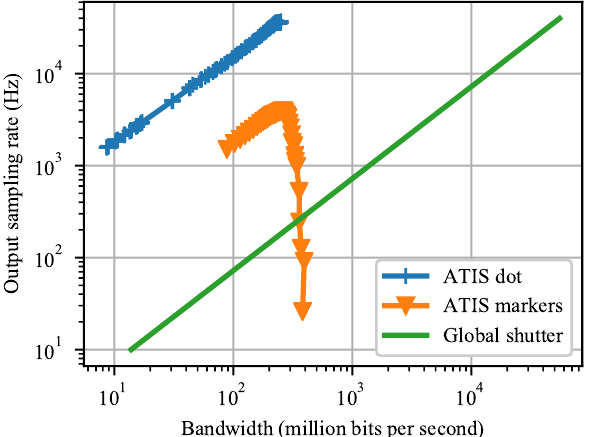
Figure 17. A bandwidth-performance plot shows how much data an event-camera (ATIS) and a global shutter frame-camera generate to reach a certain output sampling rate. The output sampling rate captures the number of marker detections or the number of rotating dot position estimates, both per second—assuming the strongest lighting tested (ATIS), 27 bits per event on average, negligible frame-camera exposure time, and sensor resolution of 480 × 360